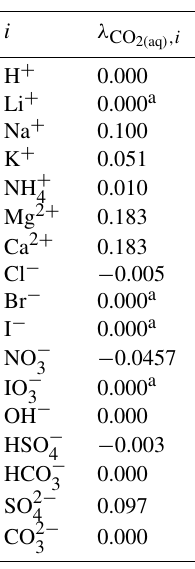
Table 5. Summary of CO 2(aq) ↔ ion interaction